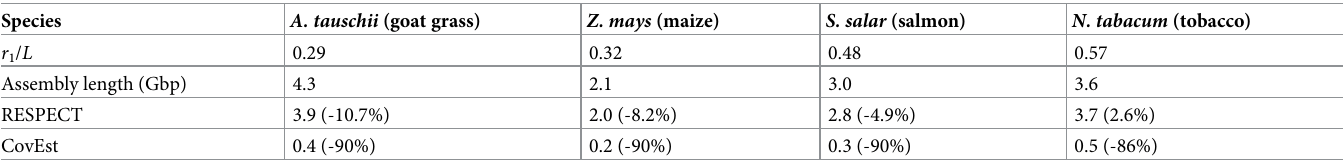
Table 1. Comparing RESPECT and CovEst accuracy on SRA’s of highly repetitive genomes. The numbers in parentheses are the percentage errors.